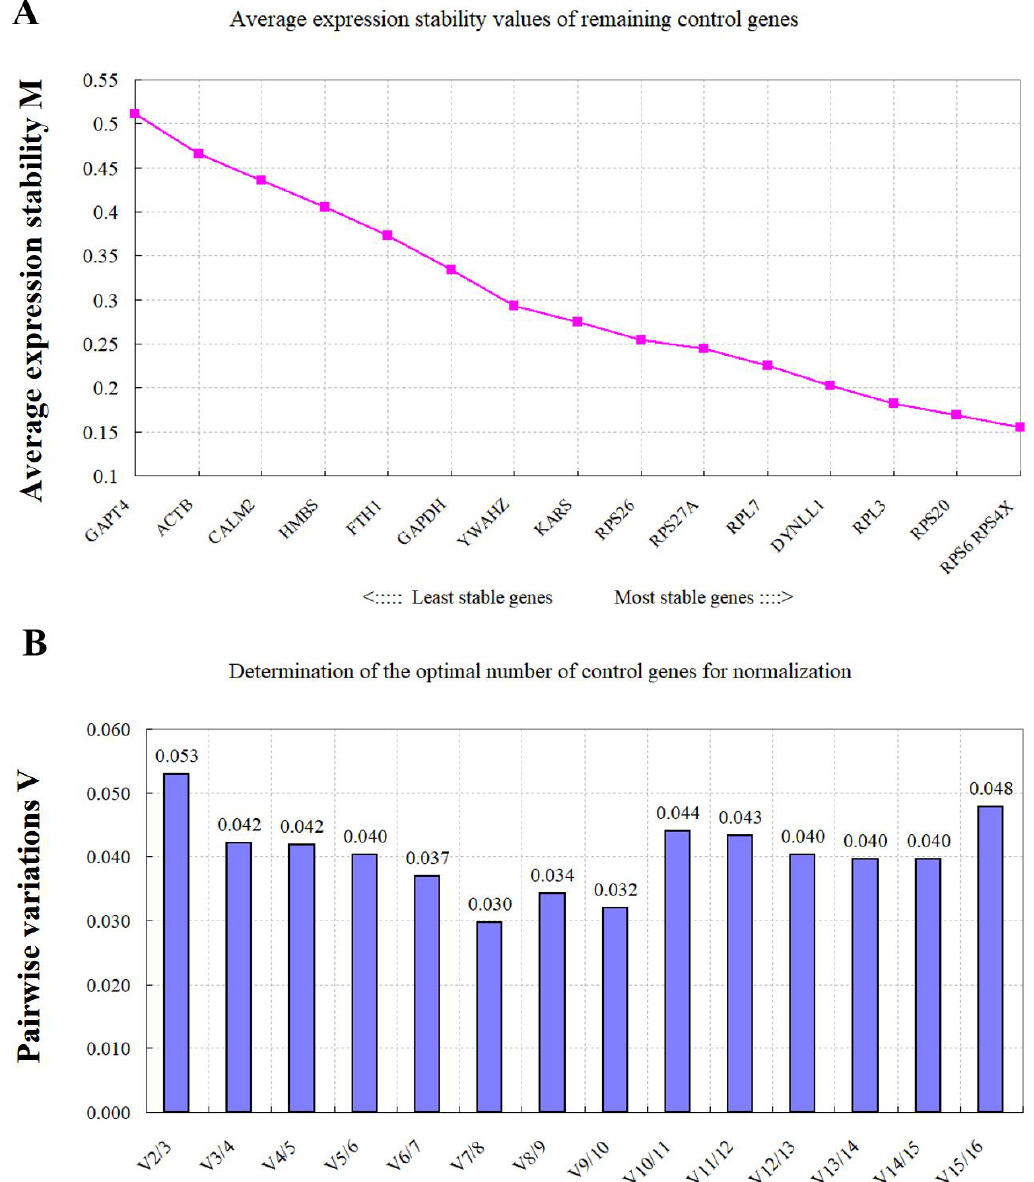
Figure 2. geNorm analysis of the expression stability of the 16 selected RGs. ( A ) The average expression stability measure (M) and ranking of the candidate RGs were calculated using geNorm. A lower M value indicated a more stable expression. ( B ) Determination of the optimal number of RGs for normalization by the pairwise variation (V) as assessed using geNorm. The optimal number of RGs was indicated by V values below 0.15 [34].